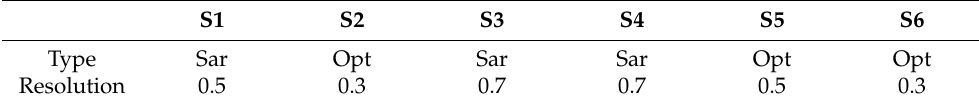
Table 6. Satellite